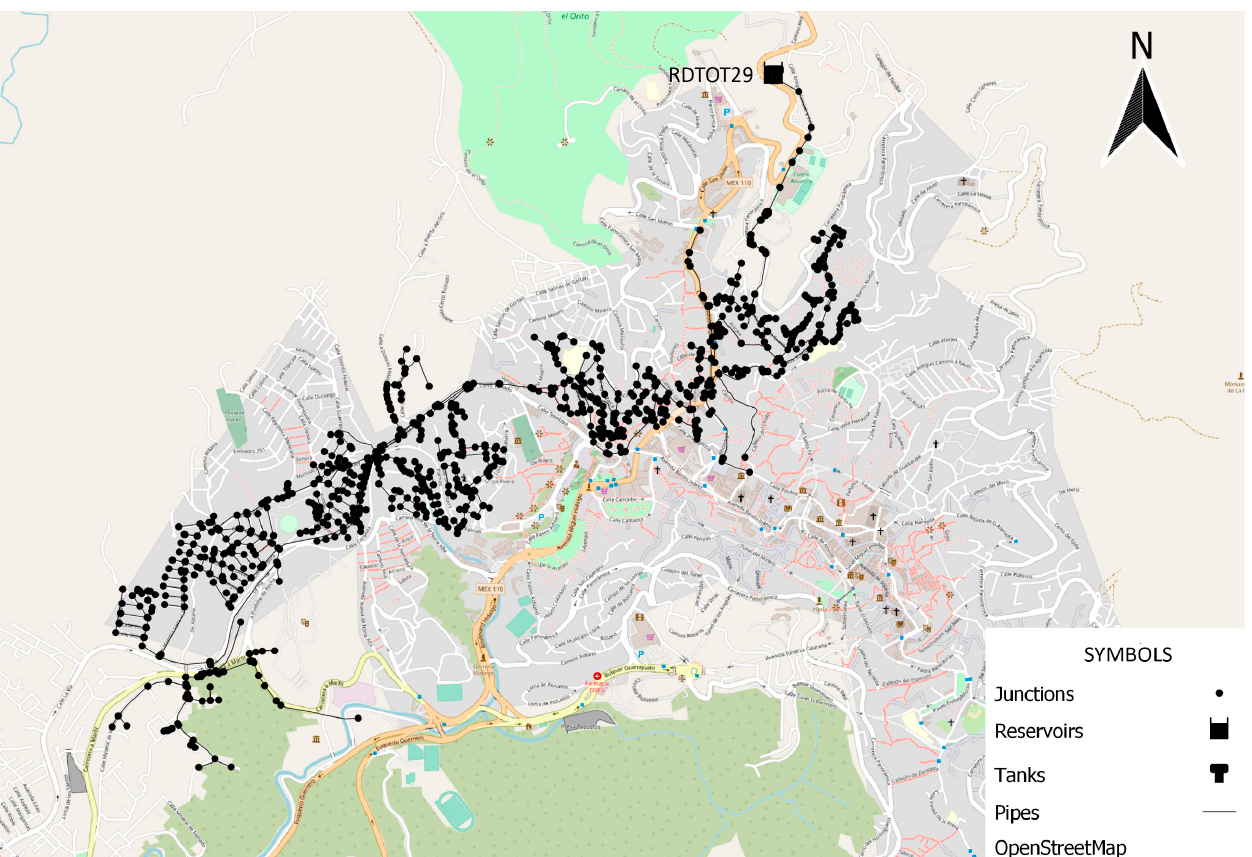
Figure 2. Real WDN “SF812” provided by SIMAPAG.